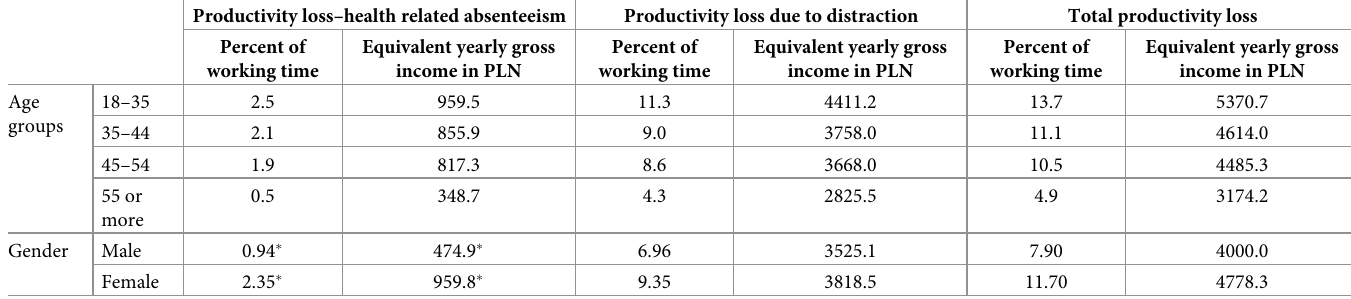
Table 3. Average productivity loss and average cost of productivity loss by gender and age group–secondary analysis of an apparel factory belonging to a global brand. Productivity loss–health related